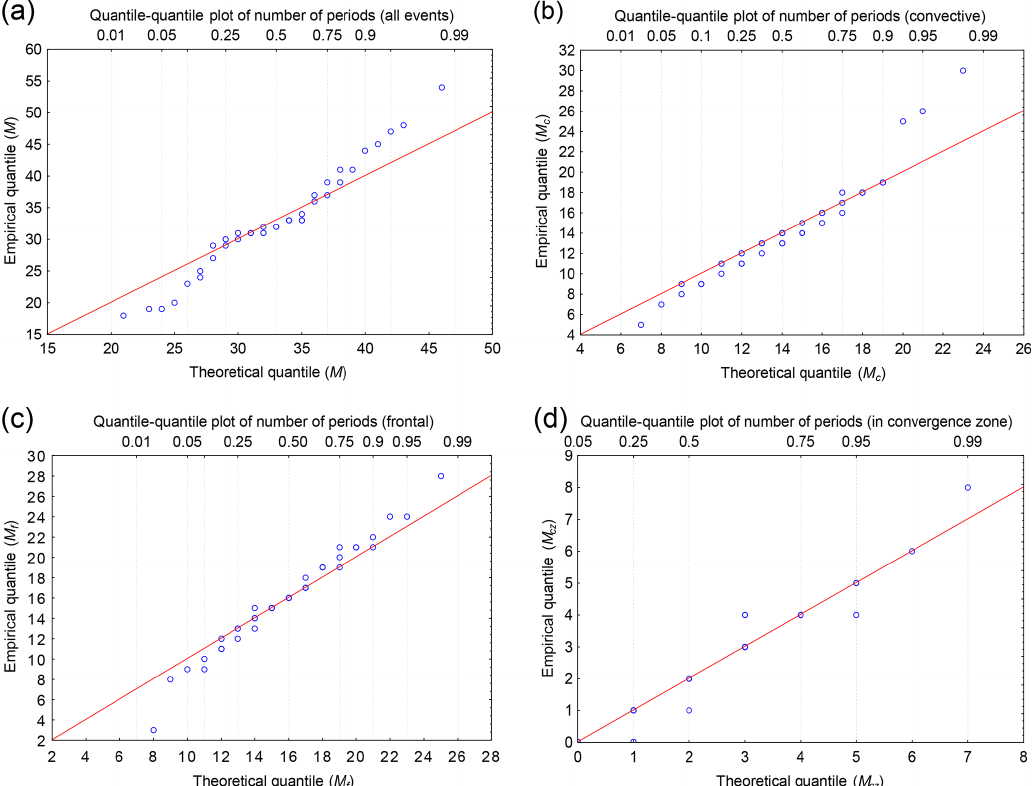
Figure 6. Comparison of empirical and theoretical quantiles concerning the number of rainfall events and distinguishing rainfall types for (a) all events, (b) convective, (c) frontal, and (d) in the convergence